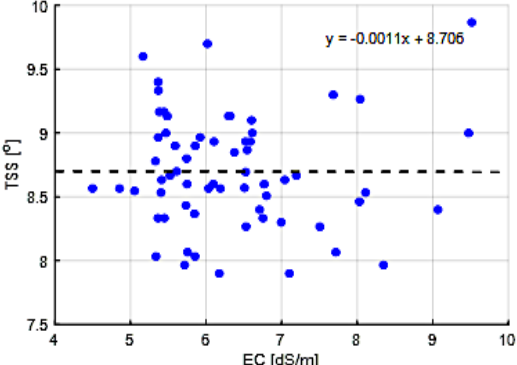
Figure 12. Correlation between total soluble solids (TSS, °Brix) and EC (dS/m) of the different greenhouse compartments (301–306).